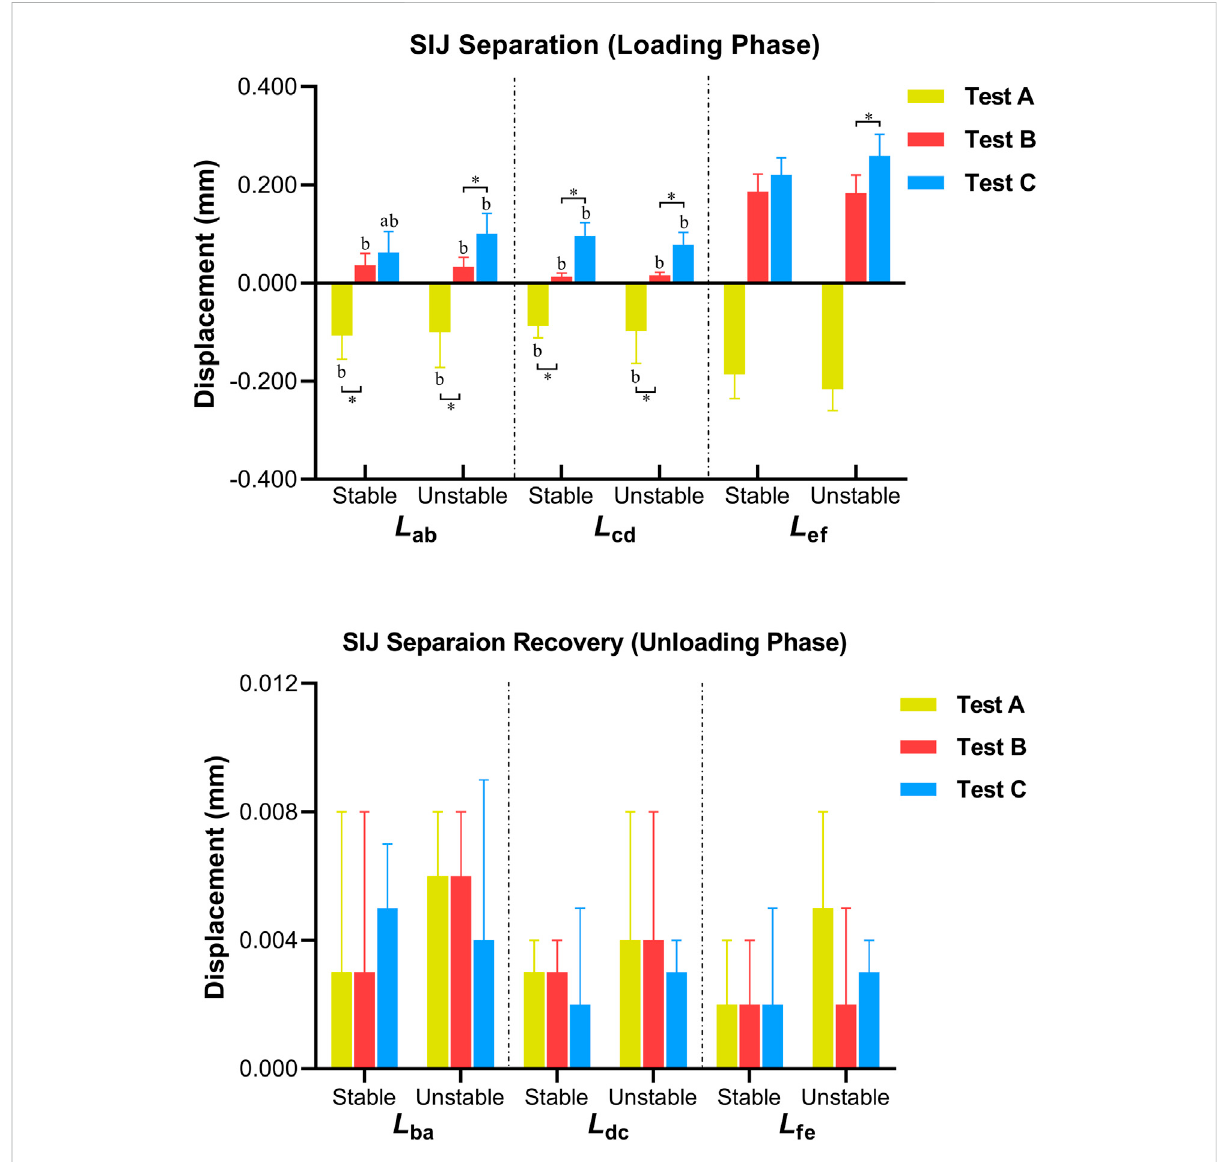
FIGURE 9 Differences in the displacement of SIJ ( a P < 0.05 vs. unstable SIJ; b P < 0.05 vs. L ef ; * p <